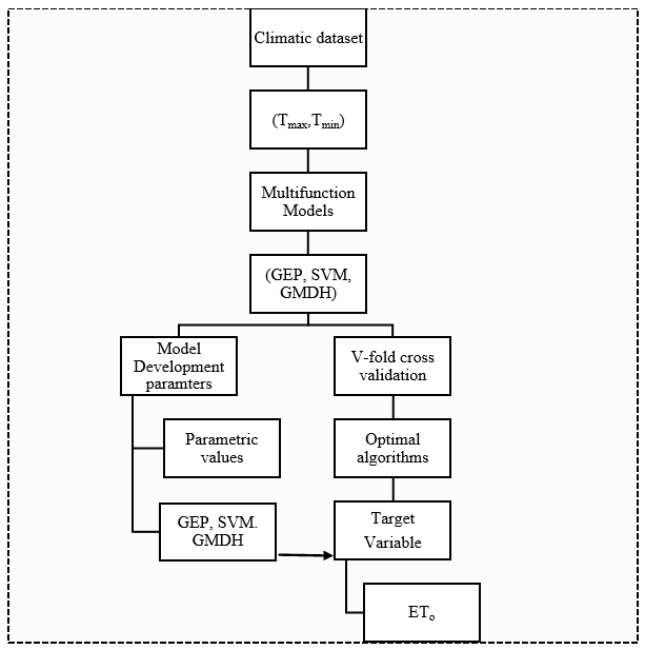
Figure 5. Topology of multifunction (MF)-based ML models in ET o modeling.